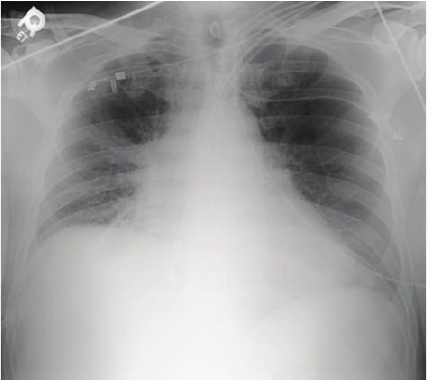
Figure 1: Chest X-ray AP view showing enlarged pericardial silhouette and right hilar mass.